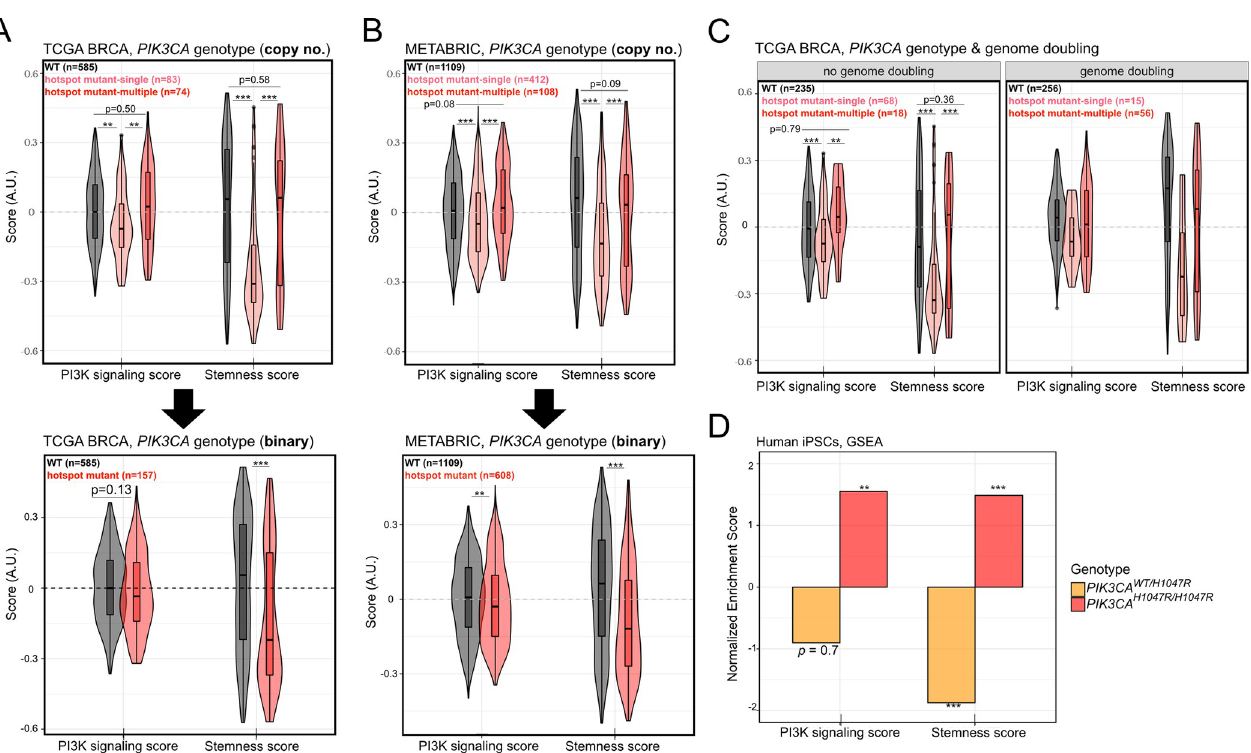
Fig 5. The presence of a single-copy, but not multi-copy, hotspot PIK3CA mutation is associated with lower PI3K signaling and stemness score. (A) PI3K signaling and stemness score distributions across TCGA breast cancers following stratification according to the presence or absence of single vs multiple copies of PIK3CA “hotspot” variants (C420R, E542K, E545K, H1047L, H1047R); �� p � 0.01, ��� p � 0.001 according to one-way ANOVA with Tukey’s Honest Significant Differences method. (B) As in (A) but performed using METABRIC breast cancer transcriptomic and genomic data. (C) As in (A) but further stratified according to available genome doubling information. The shown statistics apply to both subpanels and are the result of a two-way ANOVA, followed by Tukey’s Honest Significant Differences method to determine differences between the indicated PIK3CA genotypes following adjustment for genome doubling. (D) Complementary GSEA-based PI3K signaling and stemness score calculations using publicly-available transcriptomic data from iPSCs with heterozygous or homozygous PIK3CA H1047R expression [43]; enrichments are calculated relative to isogenic wild-type controls. �� p � 0.01, ��� p � 0.001 for individual enrichments, according to FDR = 0.05 (Benjamini-Hochberg correction for multiple